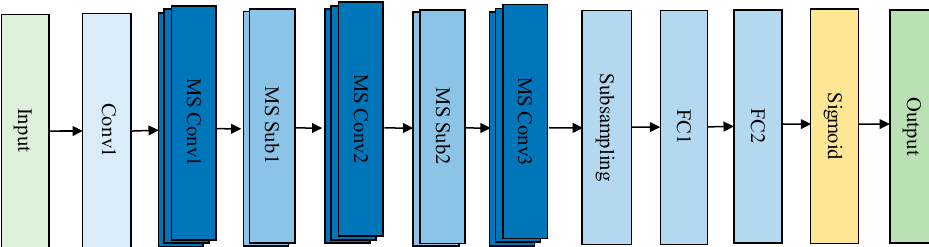
Figure 2. The structure of the proposed multi-scale convolutional neural network model, where Conv is short for a convolutional layer, MS Conv is multi-scale convolutional layer, MS Sub is multi-scale subsampling or downsampling layer, FC is fully connected layer.